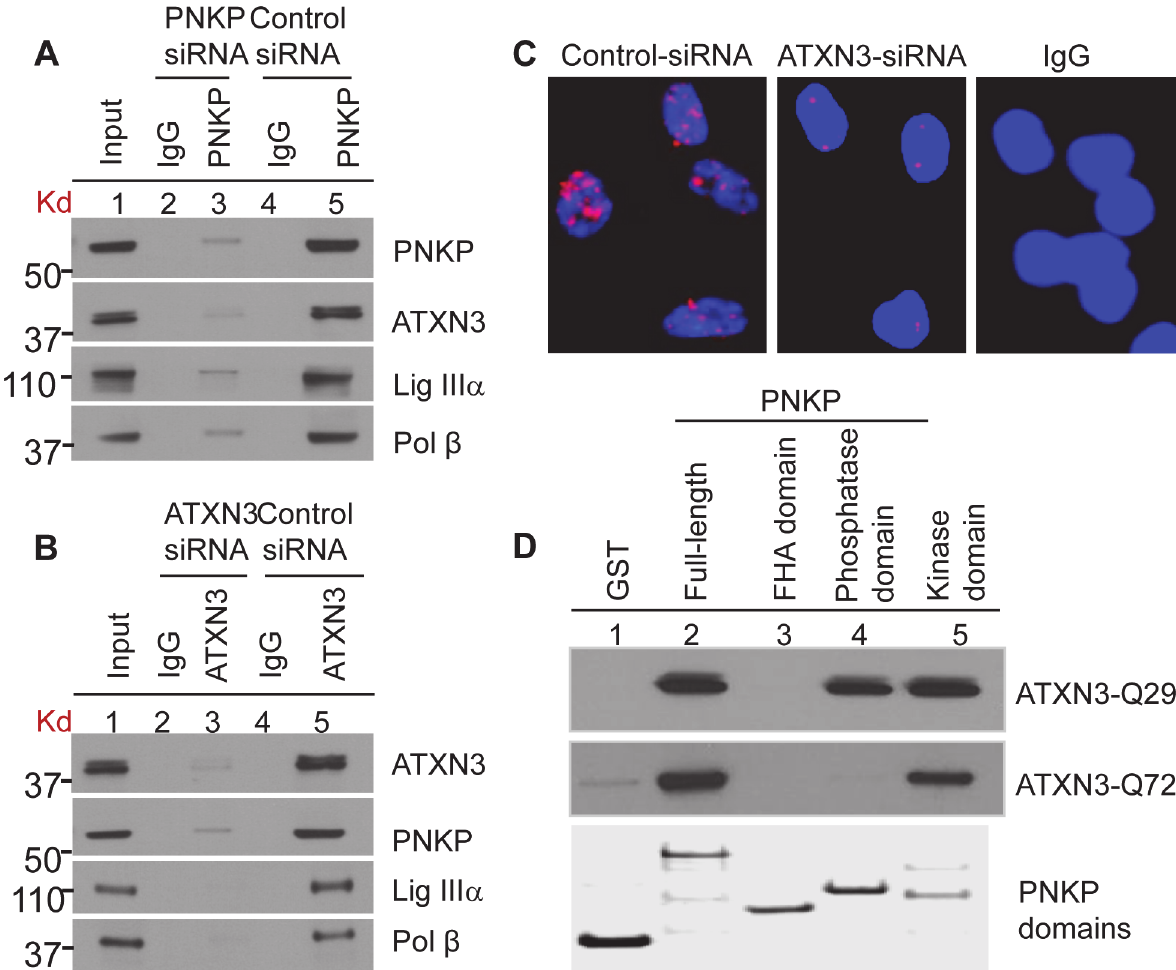
Figure 2. Characterization of the (A) PNKP and (B) ATXN3 immunocomplexes by Western blot analysis. HEK-293 cells were transfected with either PNKP siRNA or ATXN3 siRNA or control siRNA and the nuclear extracts (1 mg) prepared from those cells were IP ’ d with anti-PNKP Ab (BioBharati Life Science Pvt. Ltd, Kolkata, India; 2A ) or anti-ATXN3 Ab (Proteintech, 2B ) or with IgG as a control, and tested for the presence of PNKP- and ATXN3- associated proteins with Abs to the proteins shown on the right. (C) Detection of PNKP ’ s interaction with ATXN3 in SH-SY5Y cells by proximity ligation assays using a Duolink kit (Olink Bioscience, Uppsala, Sweden). Nuclei were counterstained with DAPI (blue). ATXN3-depleted (by siRNA) cells were used as a control to show the specificity of the interaction (middle panel). Right panel, Non-specific Ab (IgG) control (D) GST-PNKP pull-down of ATXN3 (WT